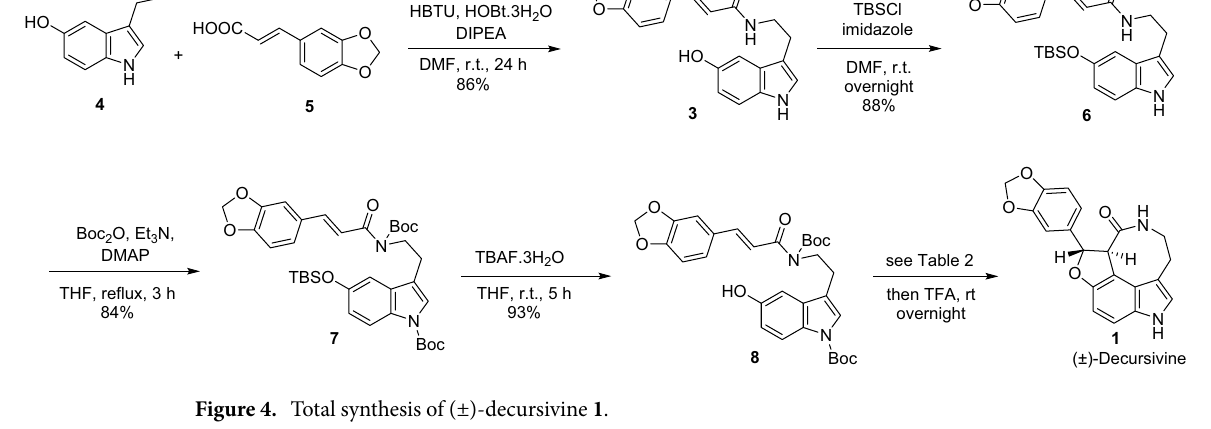
Figure 4. Total synthesis of (±)-decursivine 1 .